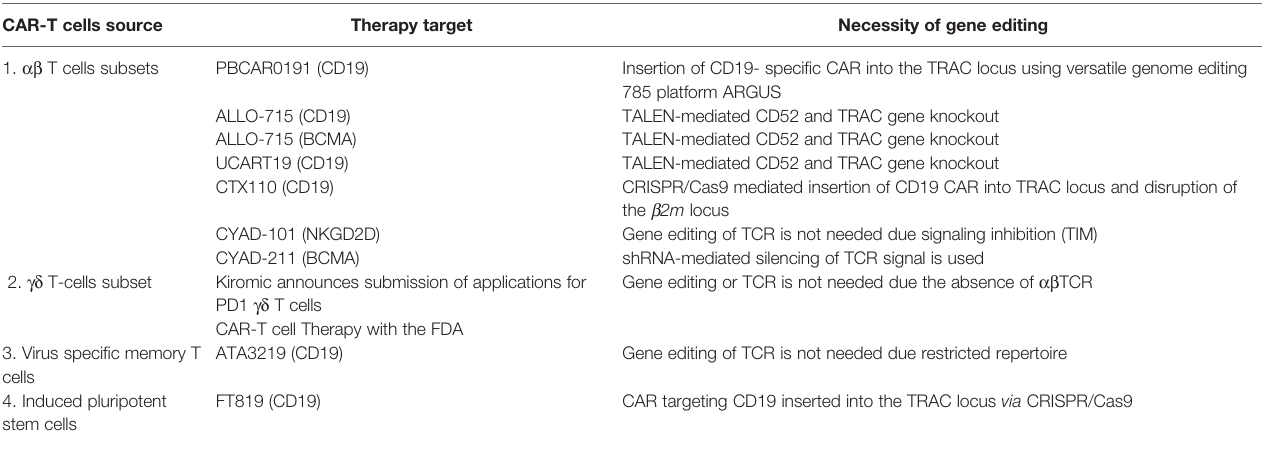
TABLE 1 | Allogeneic CAR-T cells